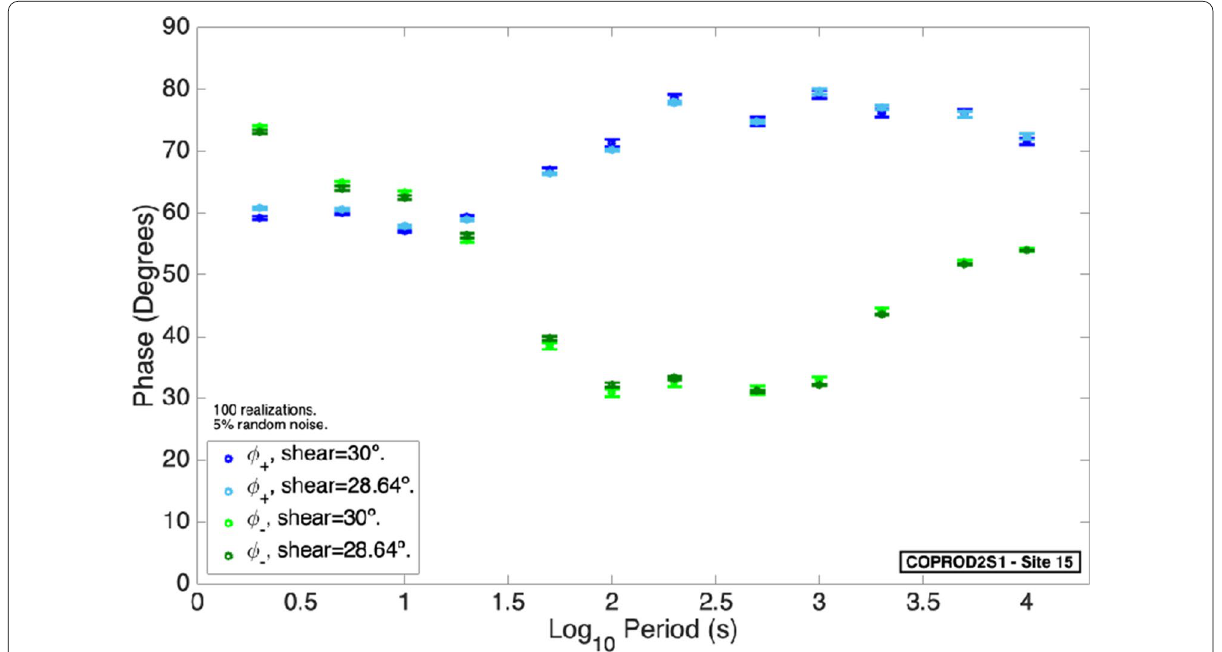
and ∅ Fig. 10 Phases ∅ for the estimated shear of 28.64º as they compare with those corresponding to the true value of + −